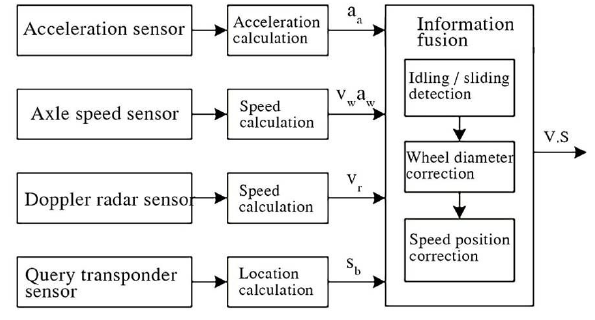
Figure 4: Principle of multi-sensor information fusion